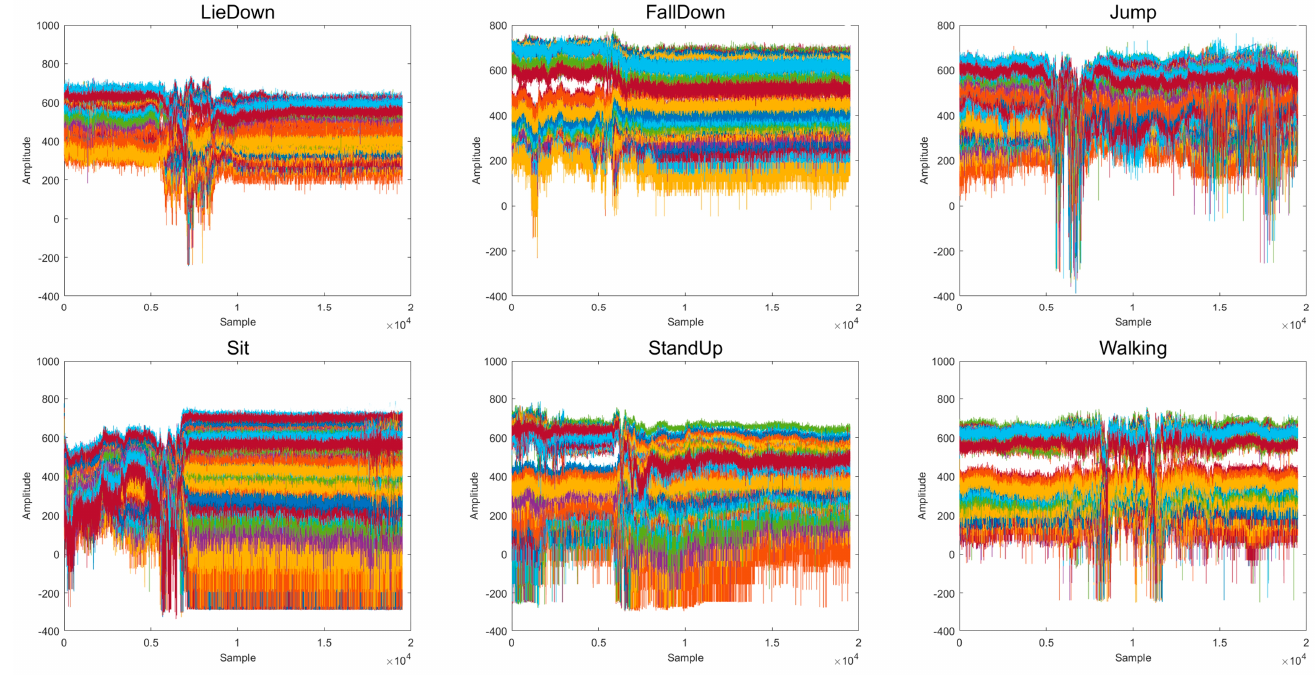
Figure 8. Correspondence between different activities and CSI signal amplitude (Each set of CSI data contains 56 subcarriers. Each subcarrier is represented by a color).